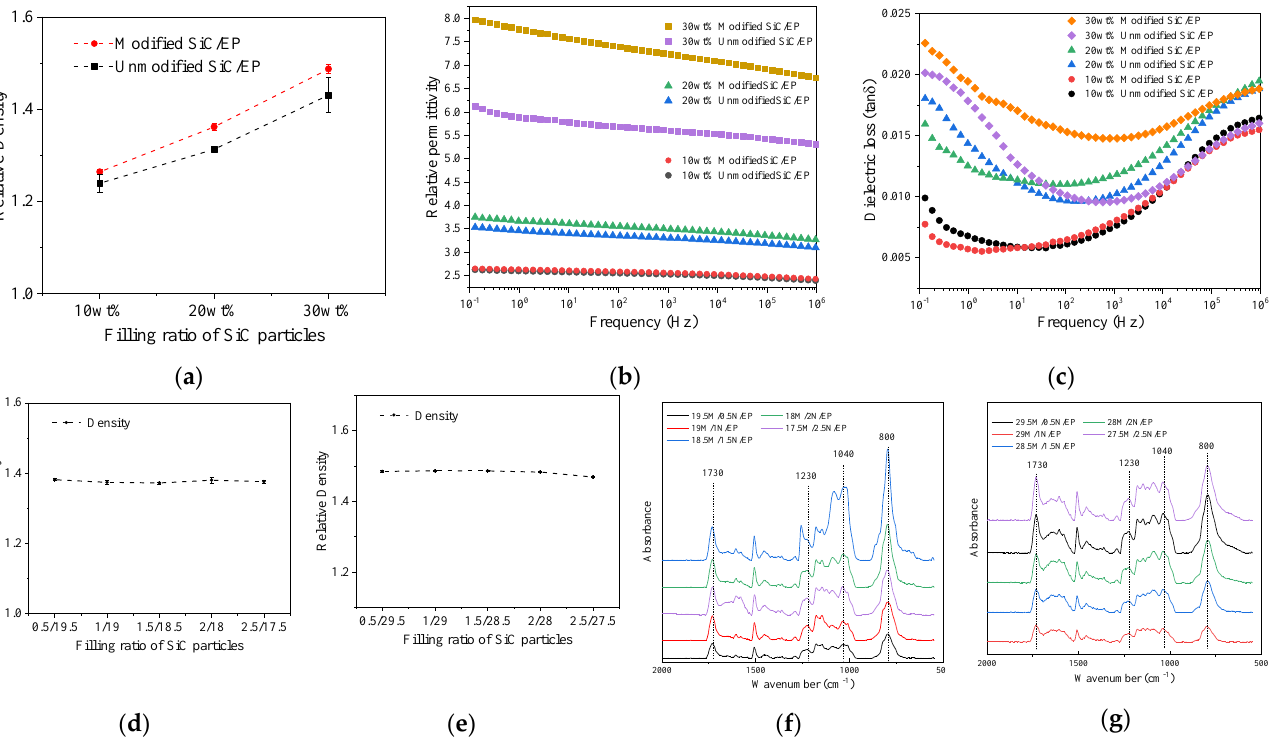
Figure 9. ( a ) Density of SiC/EP composites; ( b ) Dielectric constant of composite materials; ( c ) Com- posite dielectric loss tangent; ( d ) The total filling ratio of 20 wt%; ( e ) The total filling ratio of 30 wt%; Baseline correction and partial magnification of SiC/EP infrared spectrum: ( f ) FTIR spectra of 20 wt% filled SiC/EP; ( g ) FTIR spectra of 30 wt% filled SiC/EP.